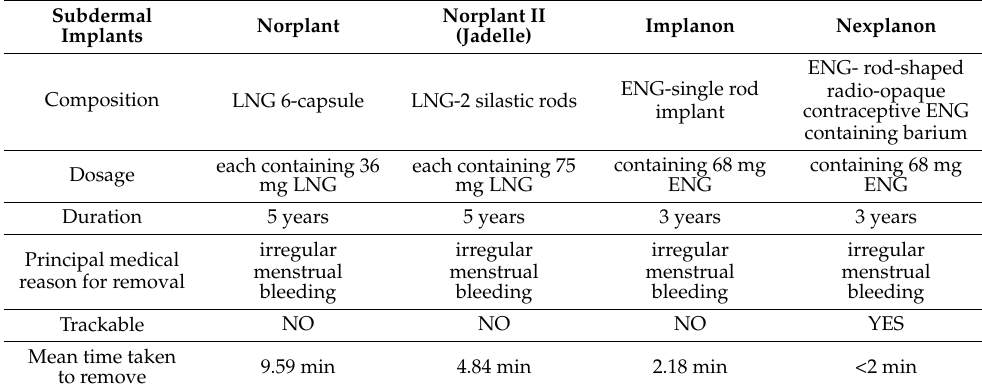
Table 1. Comparison between different subdermal implants.